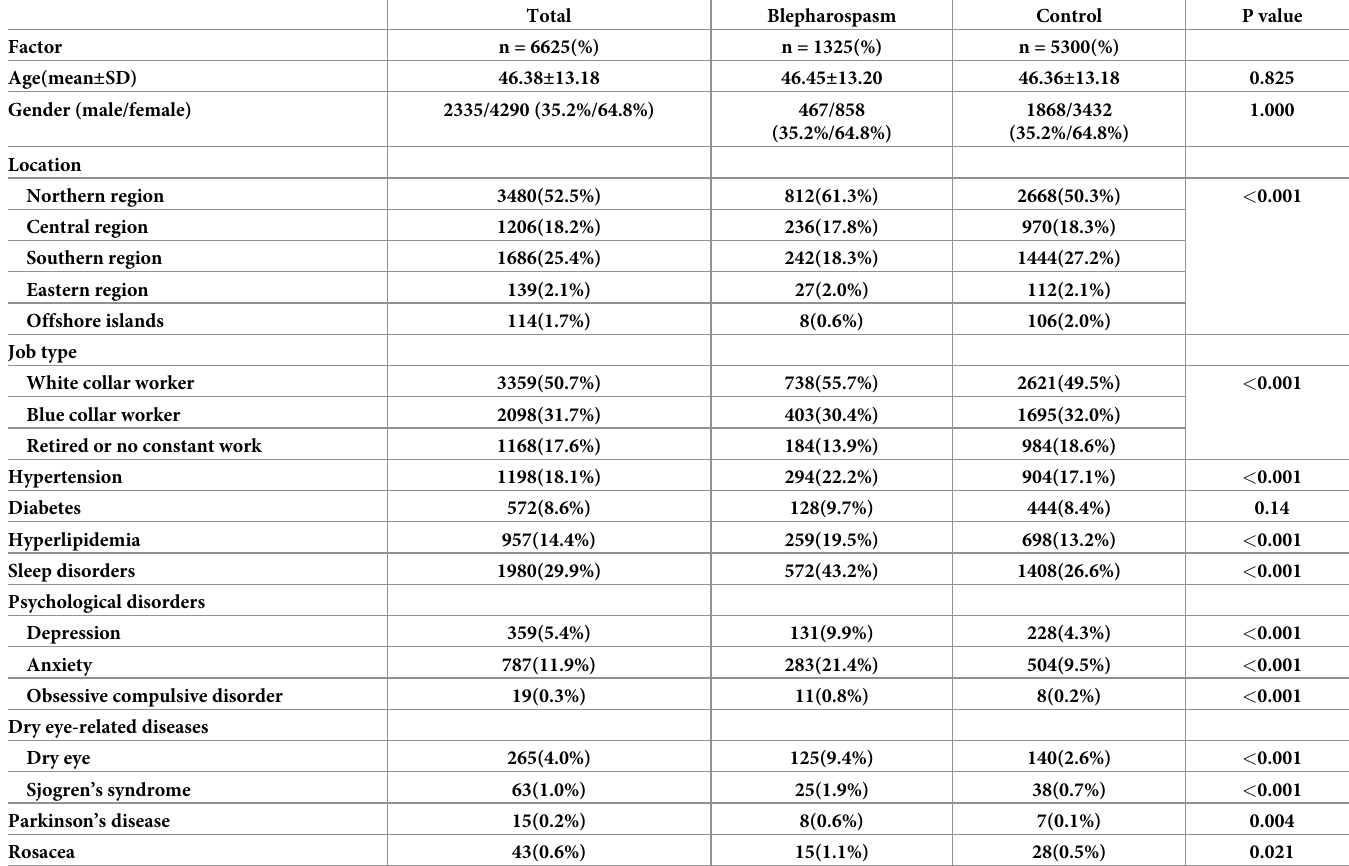
Table 1. Demographic and characteristics of benign essential blepharospasm in comparison with control